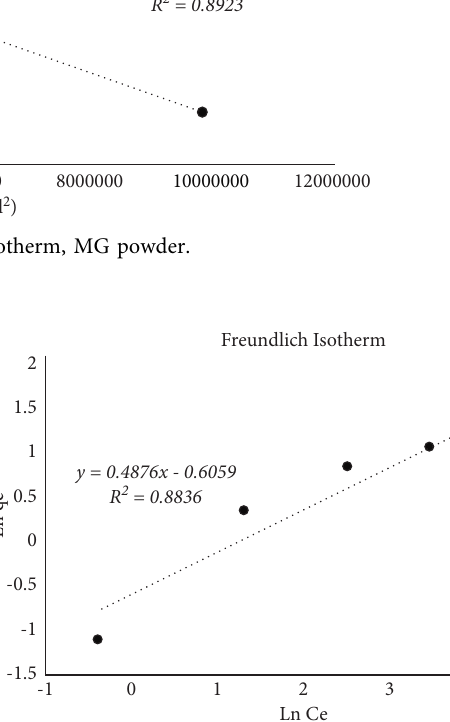
Figure 8: C e / q e variations to C e , Langmuir isotherm, TT powder.